Question: Name the type of graph shown.
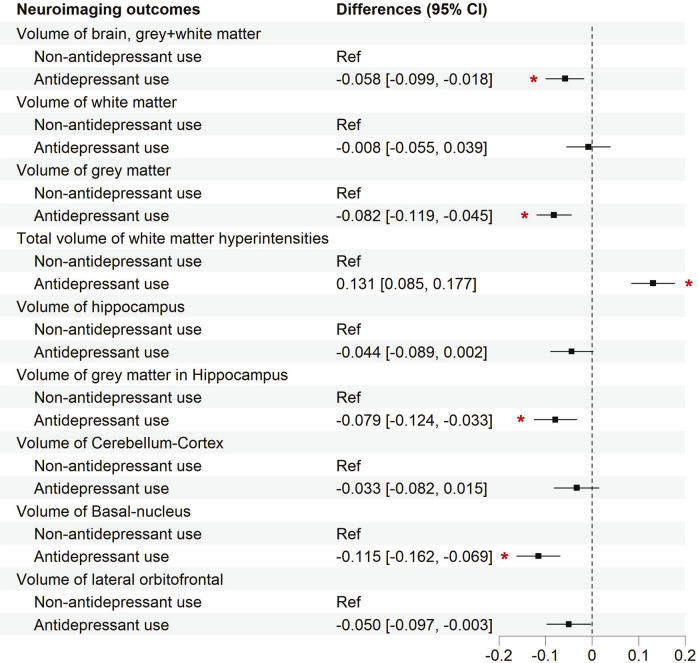
Answer: forest